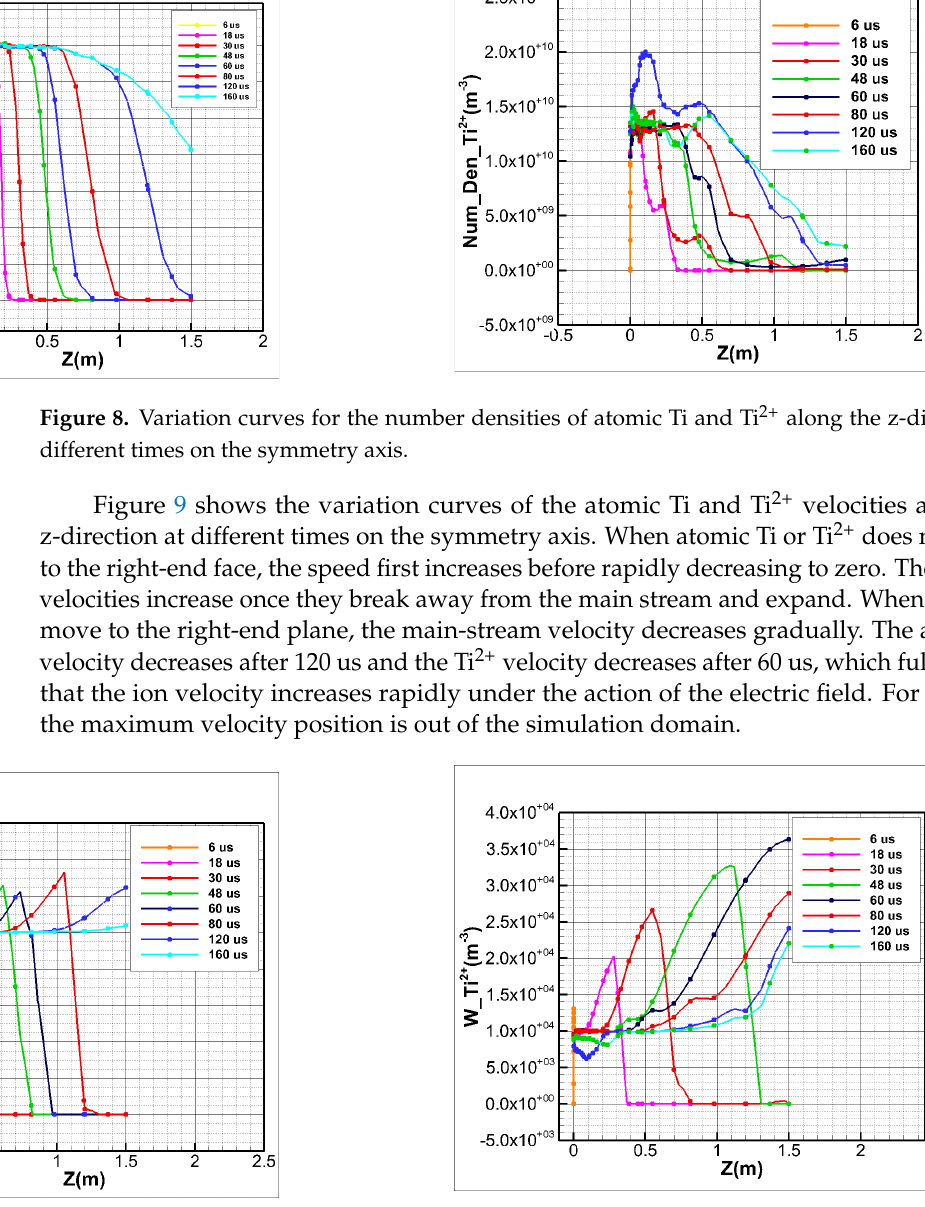
Figure 10. Variation curves of the z-direction velocity along the y-direction for a specific line. Figure 11 shows the variation curves of the atomic Ti and Ti 2+ number densities along the y-direction for a specific line. The atomic Ti and Ti 2+ number densities initially increase and then decrease along the y-direction, which is nearly symmetrical around y = 0. At t = 18 us, atomic Ti does not diffuse near the specific line, but Ti 2+ does, indicating that the diffusion speed of Ti 2+ under the action of an electric field is faster than that of atomic Ti. Over time, the number density of atomic Ti at the same position gradually in- creases to near the stable value, which is the injection surface density. The number den- sity increases rapidly near the axis of symmetry and slowly at both ends near the specific line. The Ti 2+ number density increases over time near the symmetry axis, slightly exceeds the injection surface density, increases relatively slowly on both sides, and then fluctuates near the injection surface density. At t = 18 us, Ti 2+ diffuses near the specific line but has